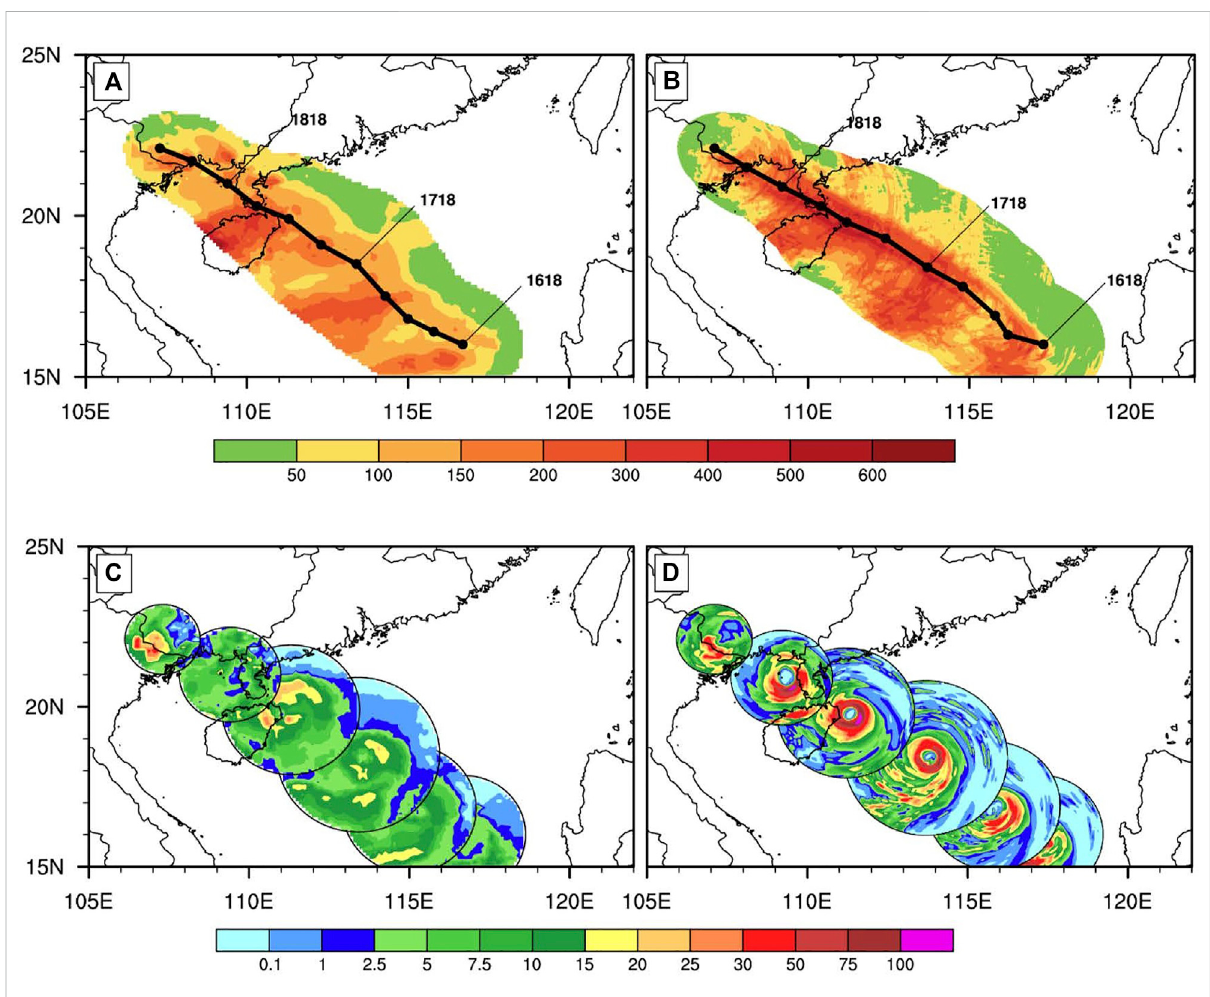
FIGURE 2 Spatial distributionof observed (A,C) and simulated (B,D) D03 cumulative rainfall (units: mm) of Rammasun in the gale circle from 1800 UTC 16 July to 0600 UTC 19 July 2014. The black lines in the (A,B) represent the observed and simulated track, respectively. (C,D) are for 12-h interval